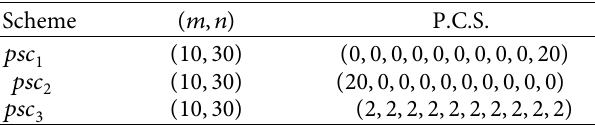
Table 1: Censoring schemes.